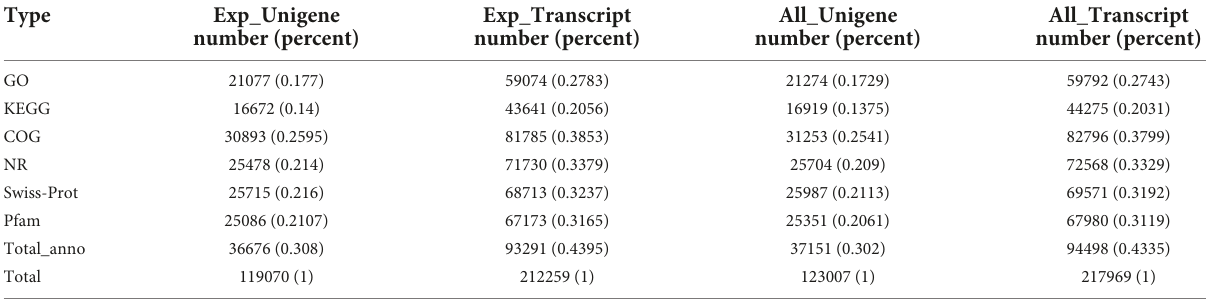
TABLE 2 Statistics of annotation